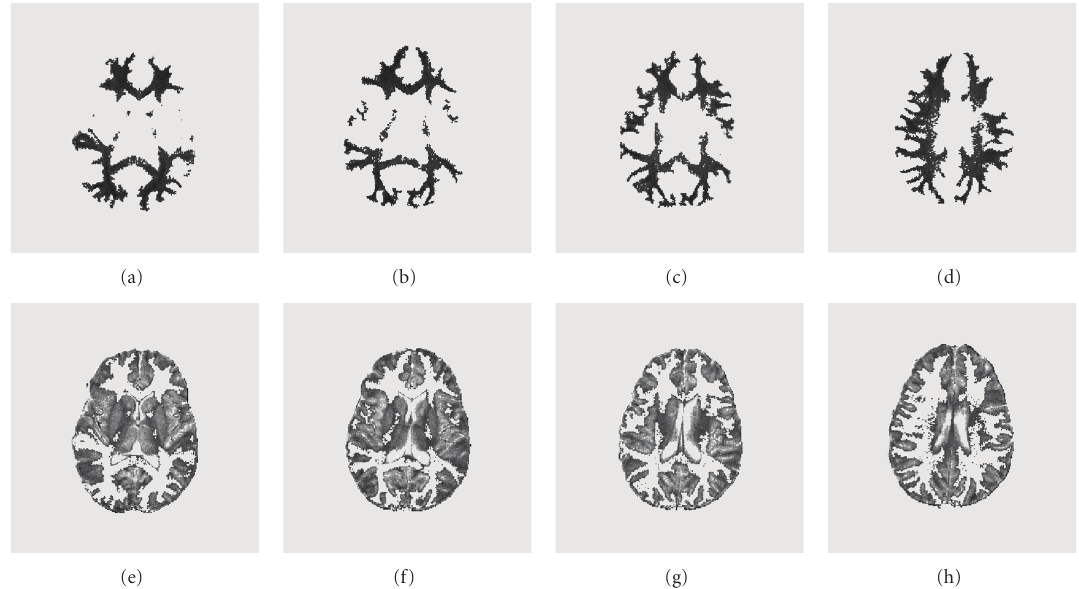
Figure 11: Segmentation result of WM (first row) and GM (second row) for the testing subject at slice number